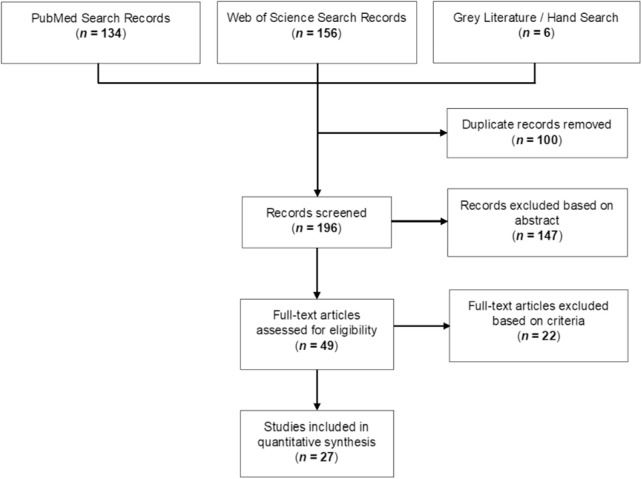
The PRISMA flowchart illustrating the literature selection process. Online databases, PubMed and Web of Science, were used for this review. Reference lists from identified publications were also reviewed to identify any GA-AI papers which may have been missed using our search keywords. AI, artificial intelligence; GA, geographic atrophy.